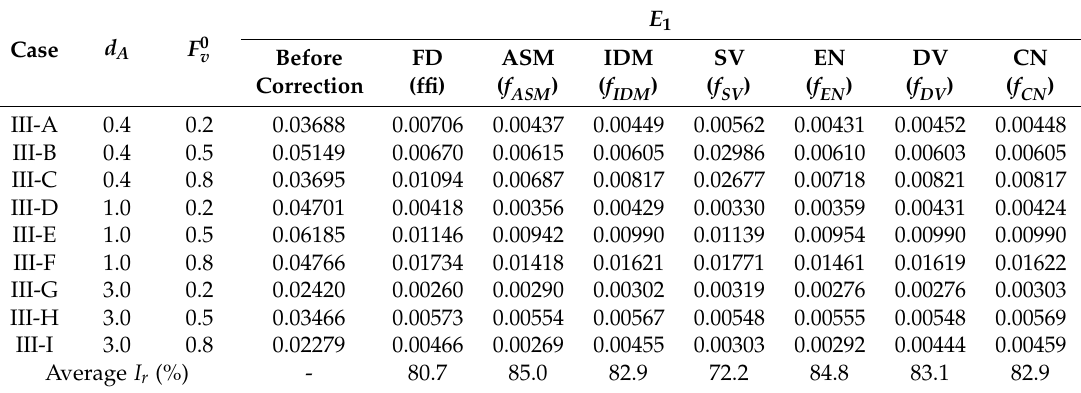
Table 4. Error index ( E 1 ) before and after correction using seven types of texture analysis indices (FD, ASM, IDM, SV, EN, DV, and CN), for Case III (spherical particles with Voronoi internal structure), along with the corresponding average improvement rate ( I r